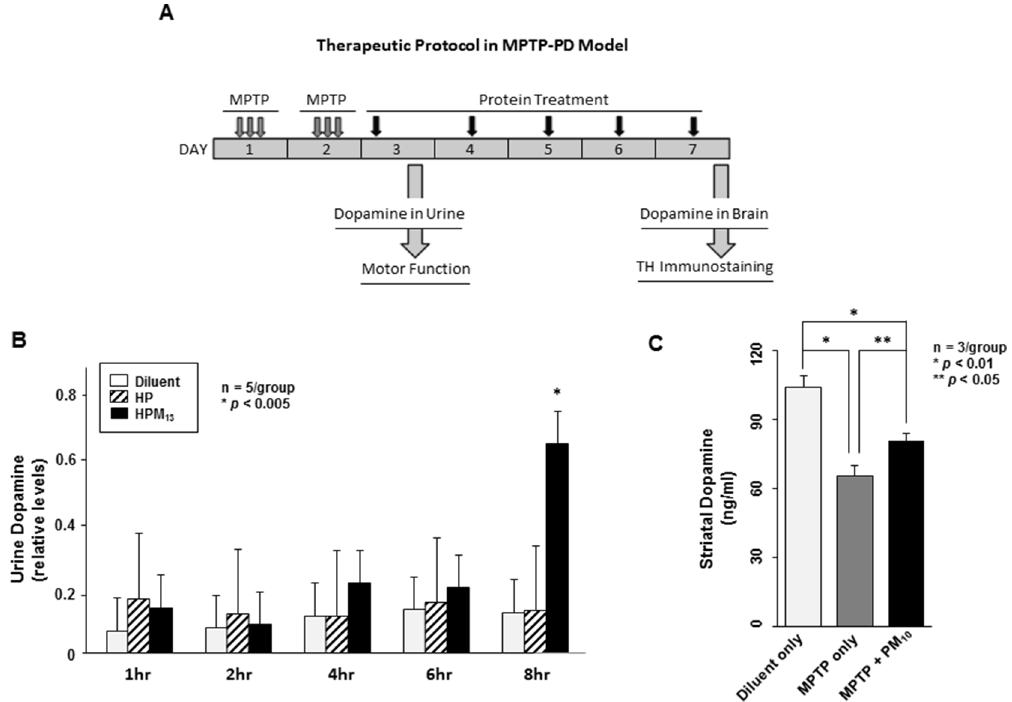
Figure 5. CP-Parkin stimulates dopamine expression in MPTP-lesioned mice. ( A ) Experimental design. 8-week-old C57BL/6 female mice received three doses of MPTP on days 1 and 2 and were injected IP on days 3 through 7 with diluent alone, or with 10 mg/kg of parkin proteins (IP) with (HPM 13 and PM 10 ) or without (HP) a MTD sequence. Urine and brain dopamine levels, gross motor function and brain lesions (TH immunostaining) were analyzed on subsequent days as indicated. ( B ) Dopamine levels in the urine of MPTP-lesioned mice. Urine dopamine levels in MPTP-lesioned mice were measured by ELISA 1, 2, 4, 6 and 8 hrs after HP and HPM 13 protein treatment. Values from 5 mice are presented as means 6 S.D. Experimental differences between groups were assessed by a Student’s two-paired t -test (* p , 0.005). ( C ) Striatal dopamine levels in MPTP- lesioned mice. Dopamine levels in striatal biopsies were determined by ELISA in lesioned mice without protein treatment or after daily treatments with PM 10 as shown in panel A. Dopamine levels in groups of 5 mice are presented as means 6 S.D. Experimental differences between groups were assessed by a Student’s two-paired t -test (* p , 0.01 and ** p ,